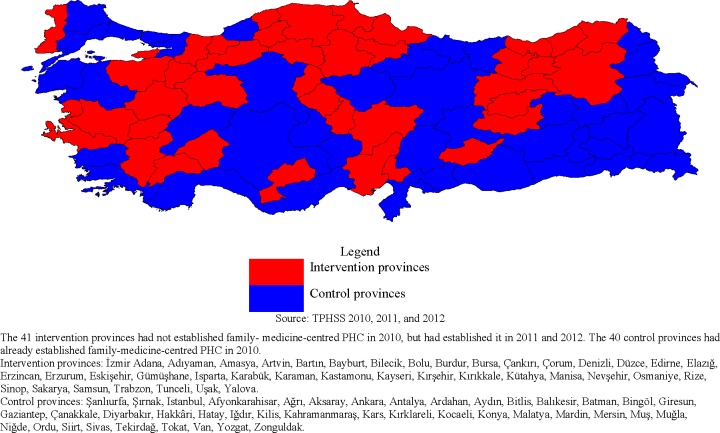
Intervention and control provinces.